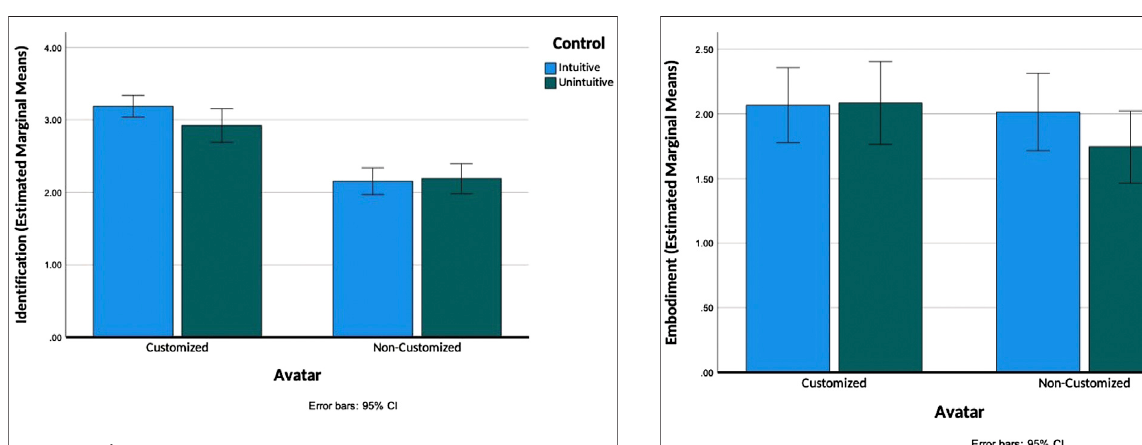
FIGURE 5 | Estimated marginal means of identi fi cation.